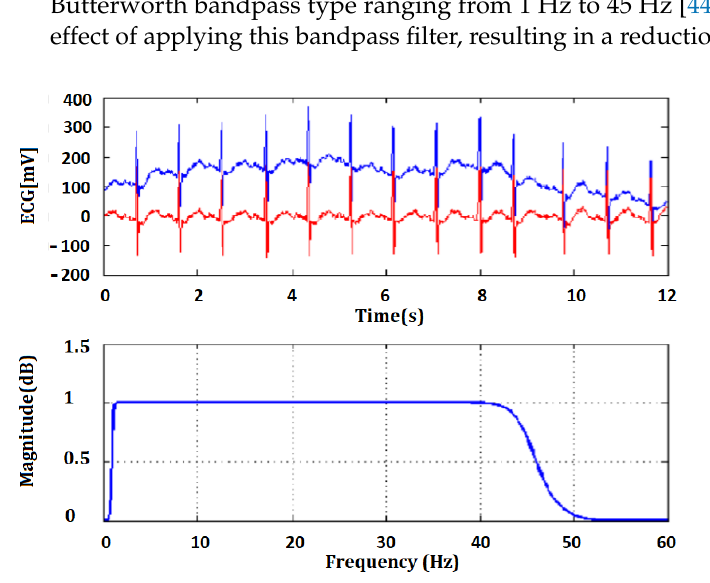
Figure 6. Bandpass filter application to a data segment from the Normal ECG class, and resulting baseline